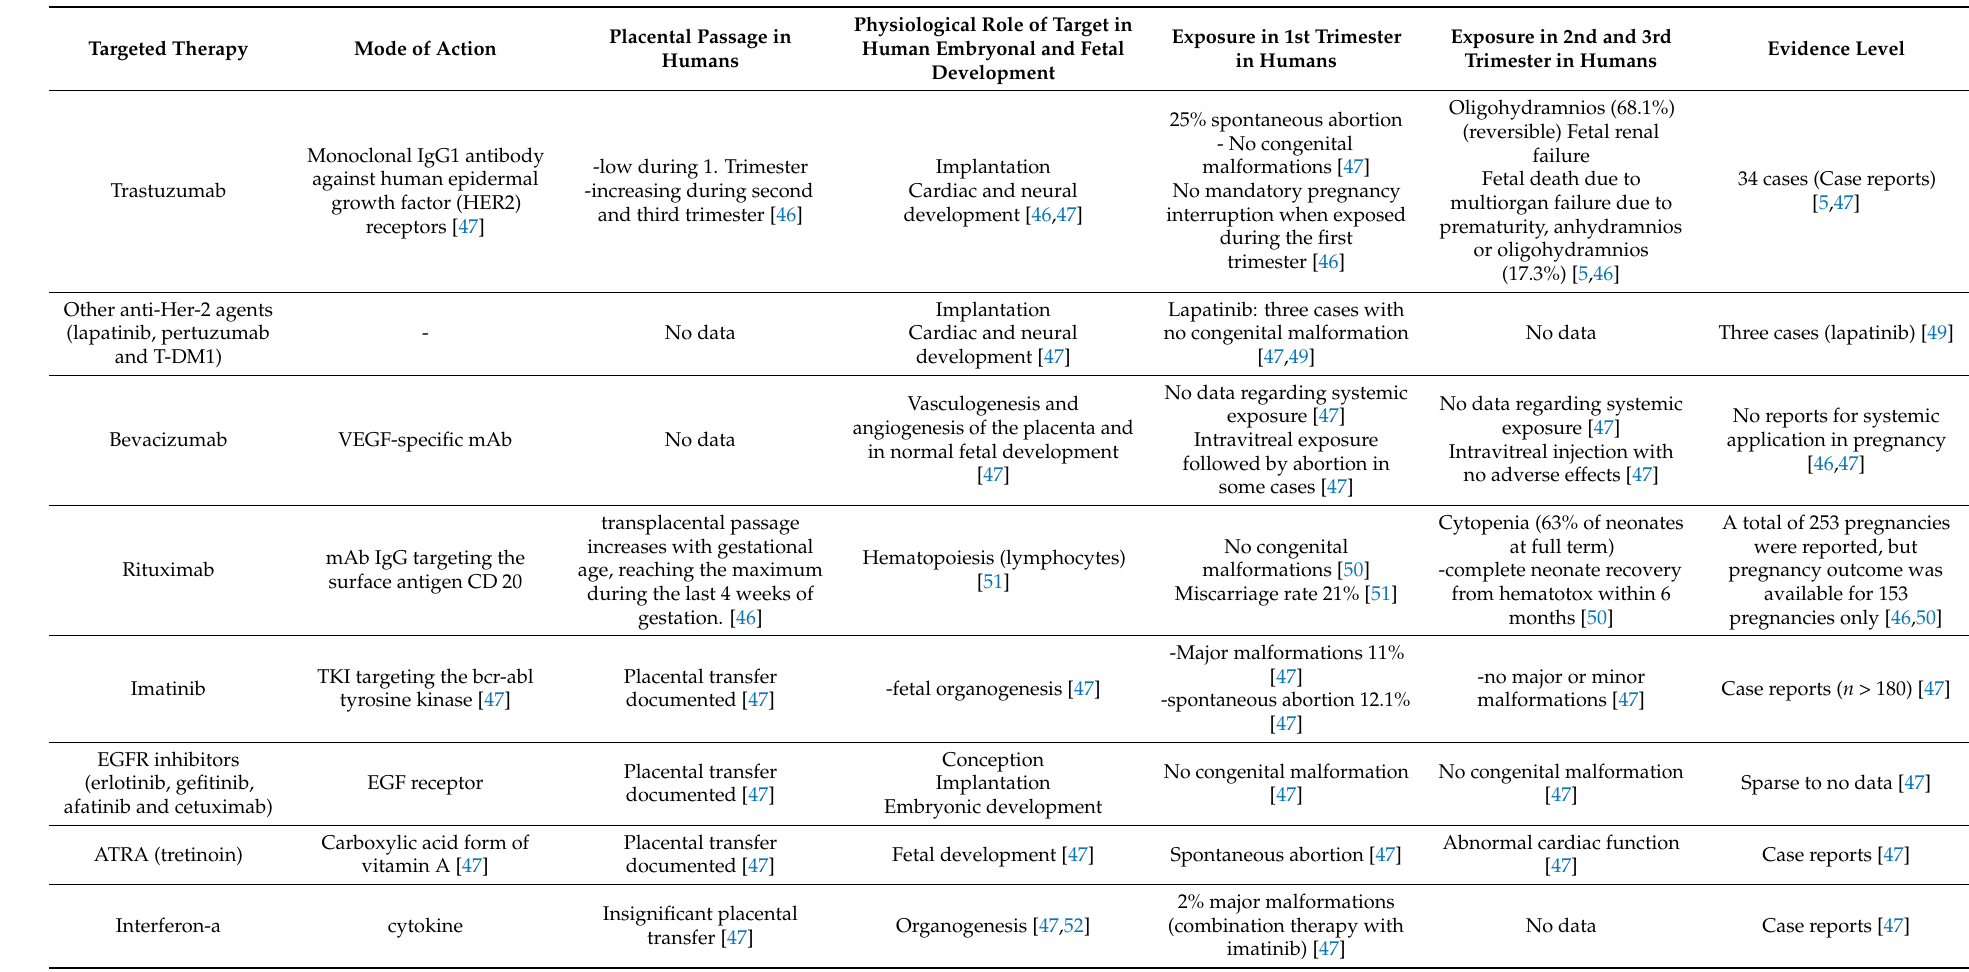
Table 2. Targeted therapies during